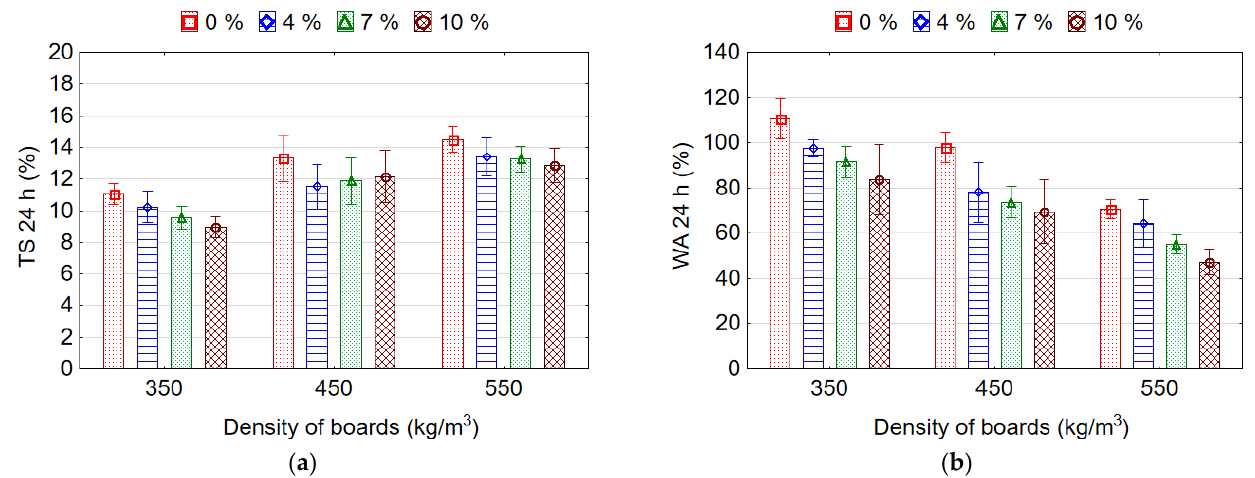
Figure 7. Thickness swelling ( a ) and water absorption ( b ) of the lightweight particleboards.